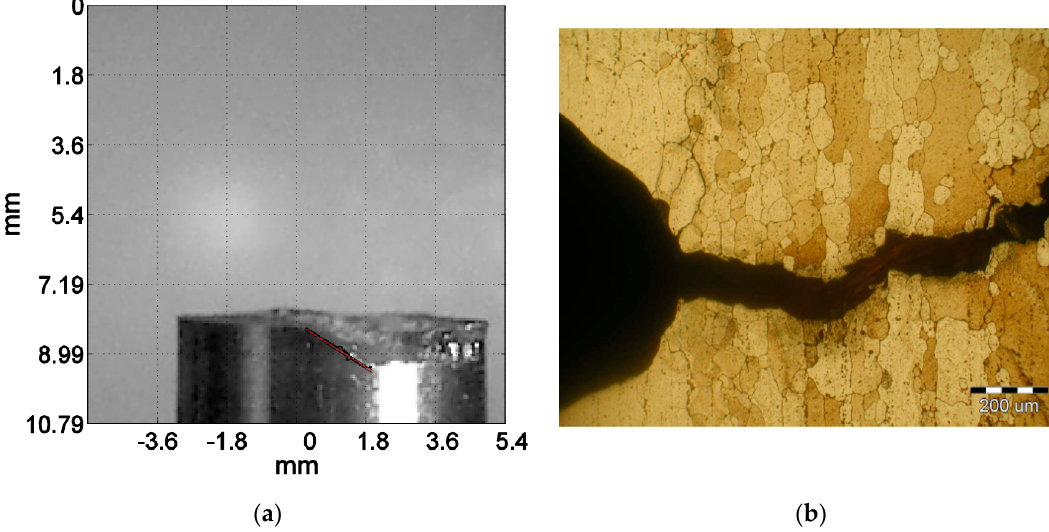
Figure 6. ( a ) Side view of S355J2 sample (lines show the place of initiation); ( b ) AW-2017A-T4 aluminium alloy.